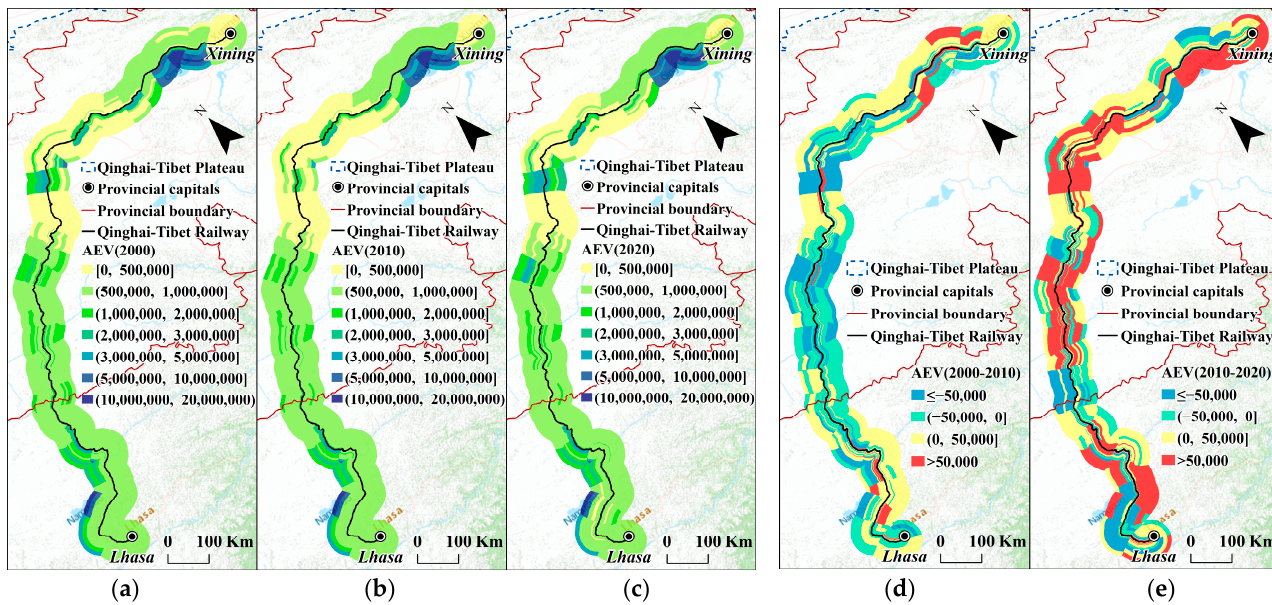
Figure 8. AEV of different road sections and different buffers. ( a ) AEV in 2000; ( b ) AEV in 2010; ( c ) AEV in 2020; ( d ) increase in AEV from 2000 to 2010; ( e ) increase in AEV from 2010 to 2020.